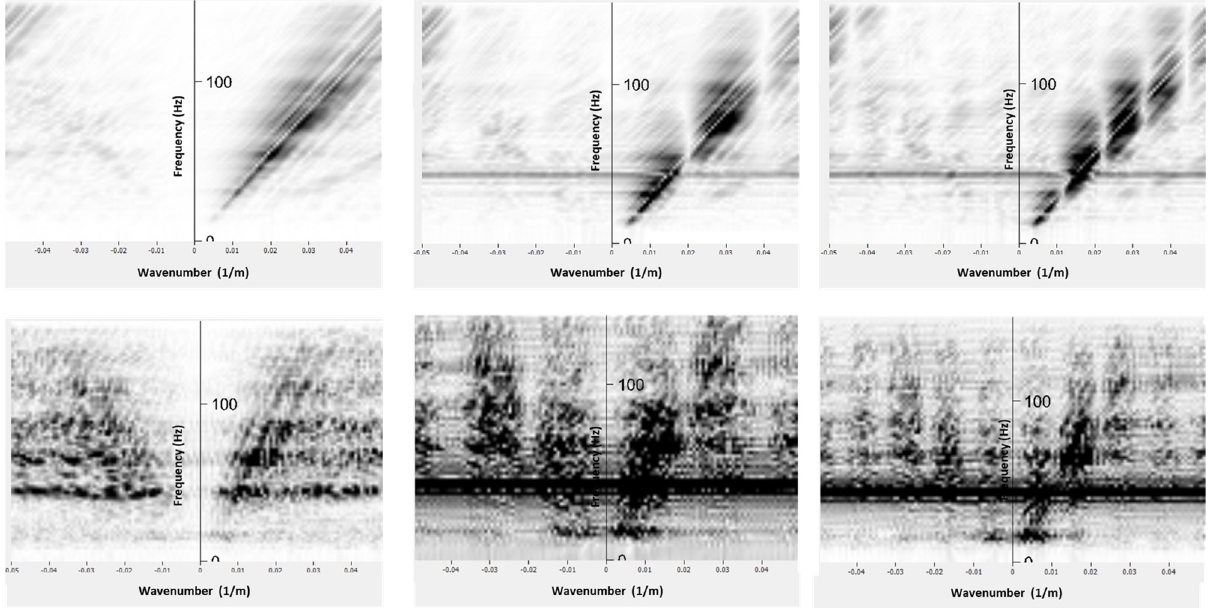
Figure 9. F-K spectrum for the converted geophone data with a simulated gauge length of 10 m ( left ), 50 m ( middle ) and 90 m ( right ) for near ( top ) and far ( bottom ) offset. 50 m ( middle ) and 90 m ( right ) for near ( top ) and far ( bottom )